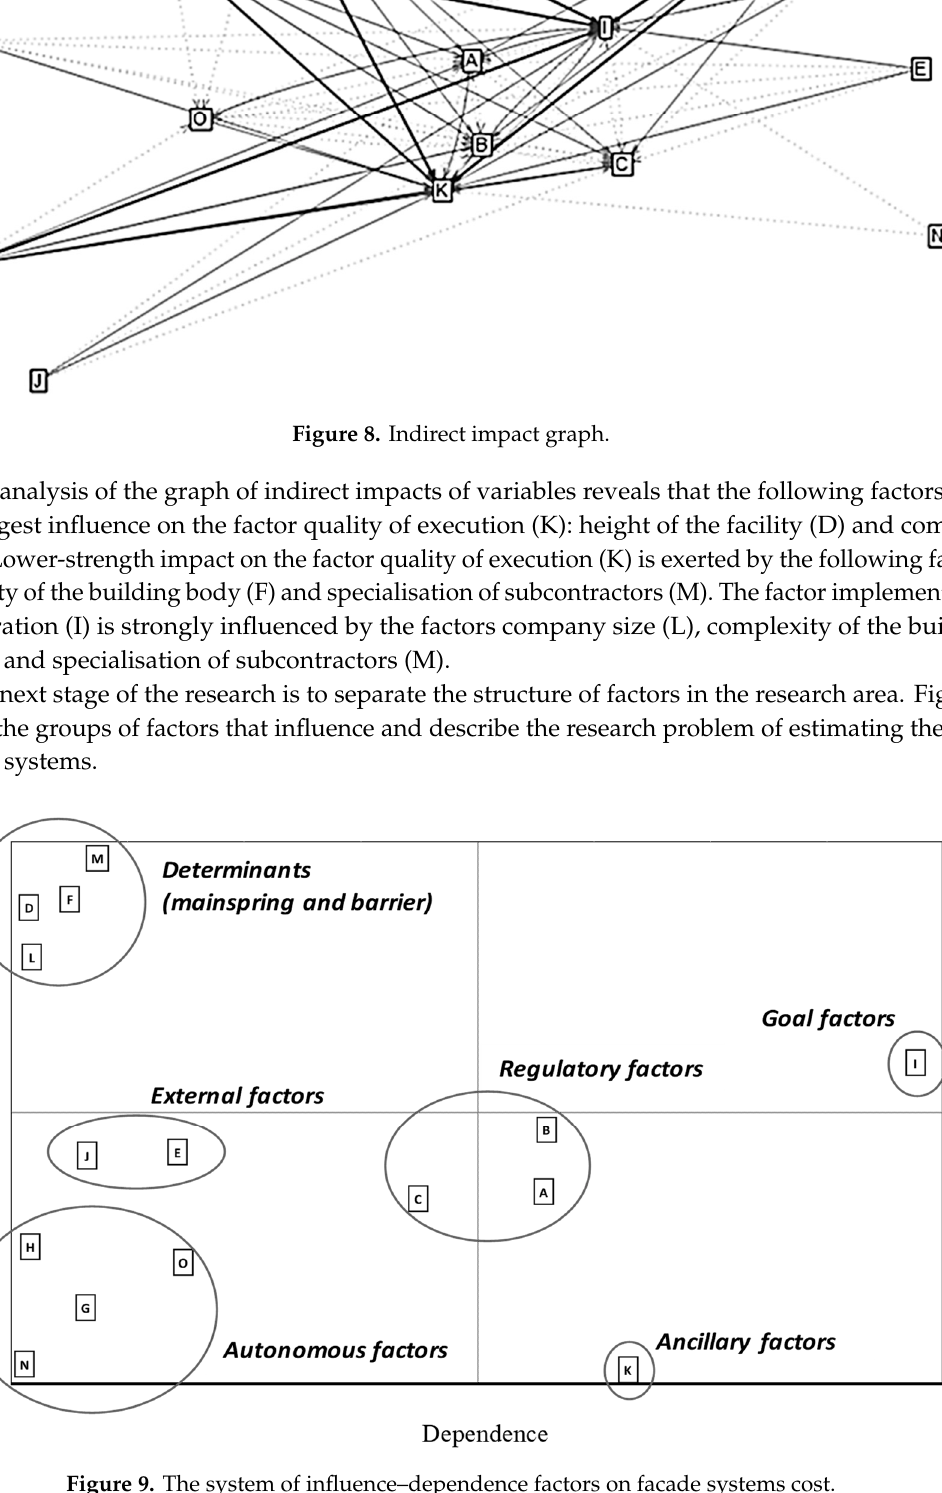
Figure 9. The system of influence–dependence factors on facade systems cost.